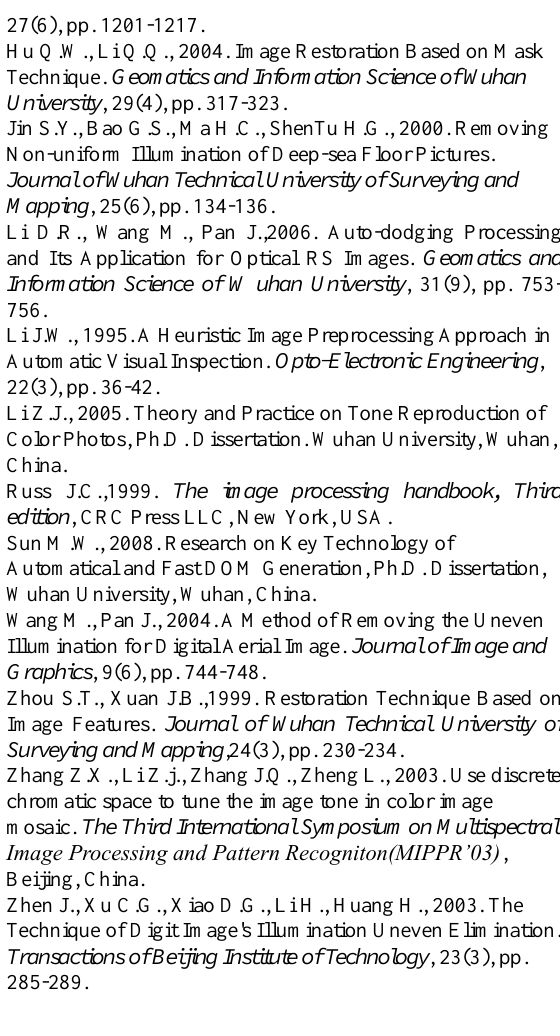
algorithm based on Mask technique. The background image is obtained based on the definitions of different image regions. In this way, it can reflect the lightness trend of the image more accurately. In addition, stretching the image after subtraction with different linear transformation models improves the uneven contrast phenomenon in the original